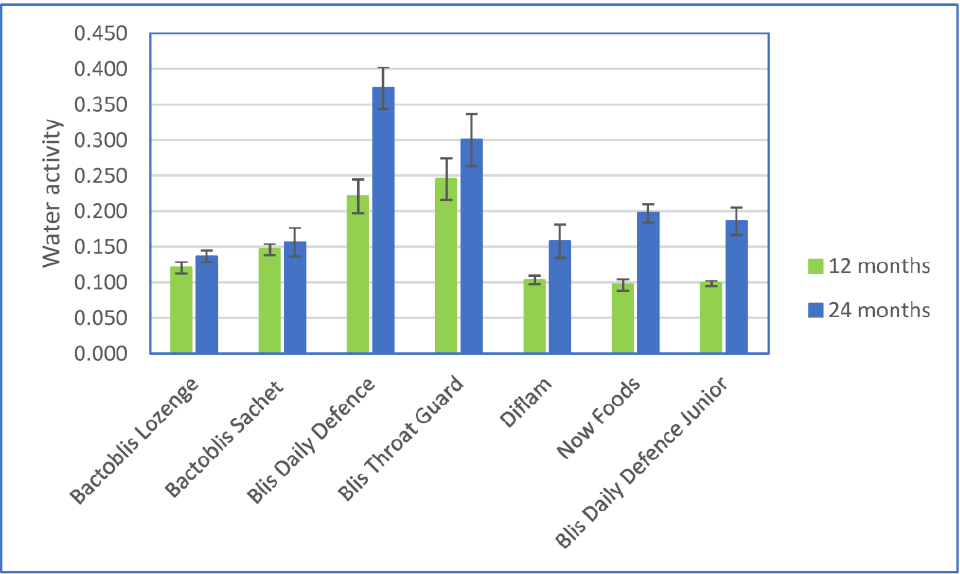
Figure 1. Water activity of the analyzed commercial products, measured at 12 and 24 months AM. The results are presented as mean values ± standard deviation.